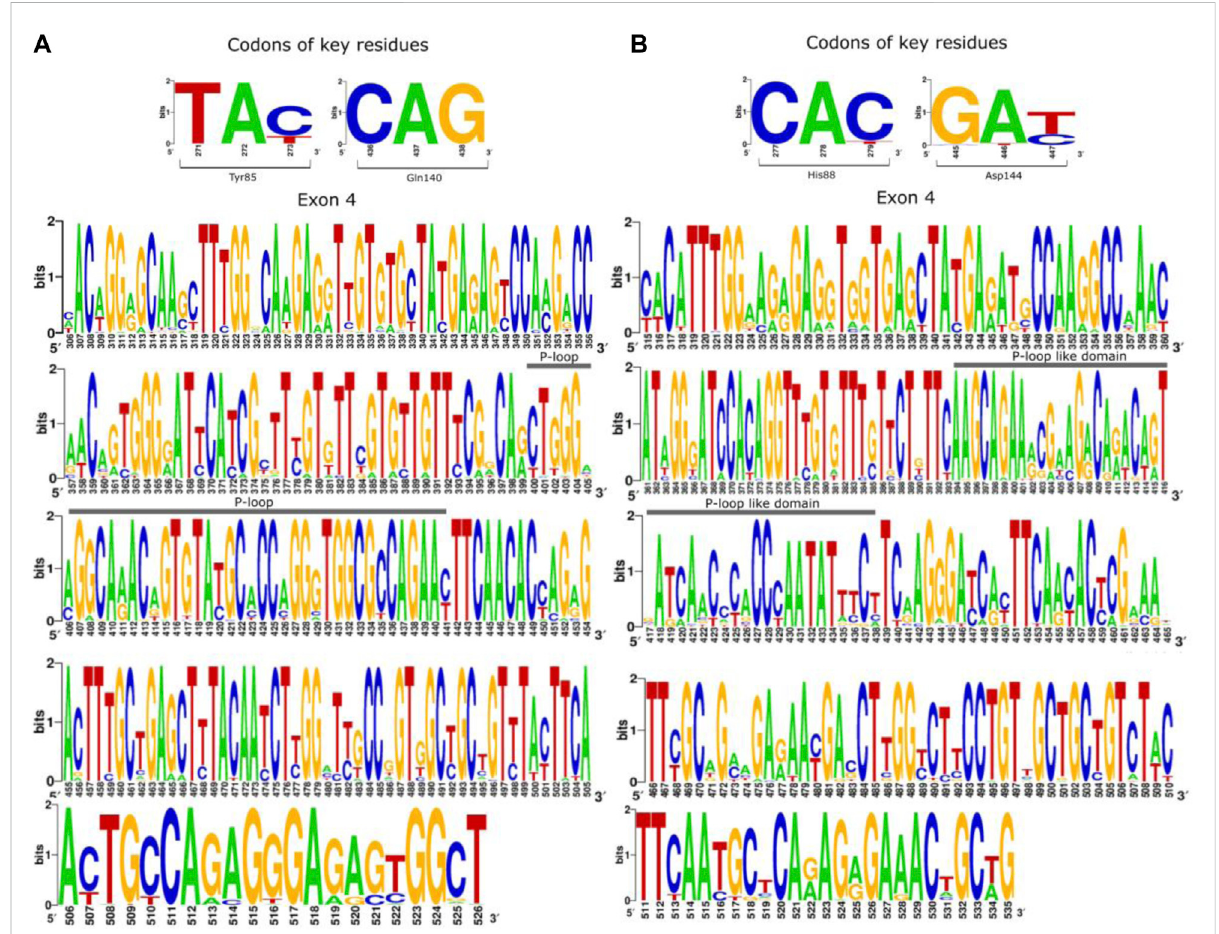
FIGURE 4 The 4th exon that encodes the P-loop domain in FT structure is well-conserved over the evolutionary history of angiosperms. Schematic overview of ancestral codon sequences of the 4th exon showing the conserved regions of FT (A) and TFL1 (B) . The height of each nucleotide within thepictogramindicatestheirrelativefrequencyintheanalyzedposition.Itisimportanttonotethat thenumberingoftheresidues fromtheP-loopis different in the angiosperm sequences, however, its position remains the same for all analyzed sequences.